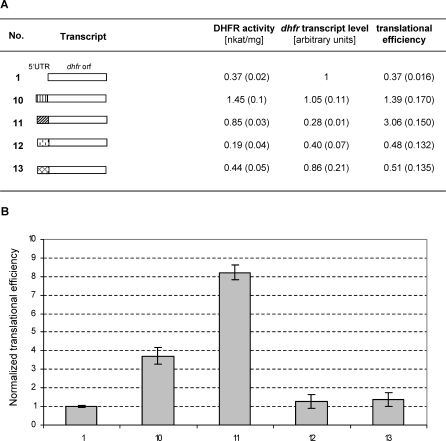
Translational Efficiencies of Artificial UTRs of Random Sequences in H. volcanii
Four 5′-UTRs of random sequence were generated and cloned upstream of the reporter gene dhfr.
(A) The transcripts are shown schematically. The DHFR activities, the transcript levels and the translational efficiencies are tabulated. Three biological replicates were performed and average values and standard deviations (in parentheses) were calculated.(B) The translational efficiencies are shown after normalization to the control transcript devoid of a 5′-UTR.(C) The sequences of the four random 5′-UTRs are tabulated including the start codon (bold) are shown. On top, the sequence of eight nucleotides that are complementary to the 3′-end of the 16S rRNA is shown. The optimal spacing between SD sequence and start codon in archaea is unknown, therefore the optimal spacing determined with E. coli has been chosen.